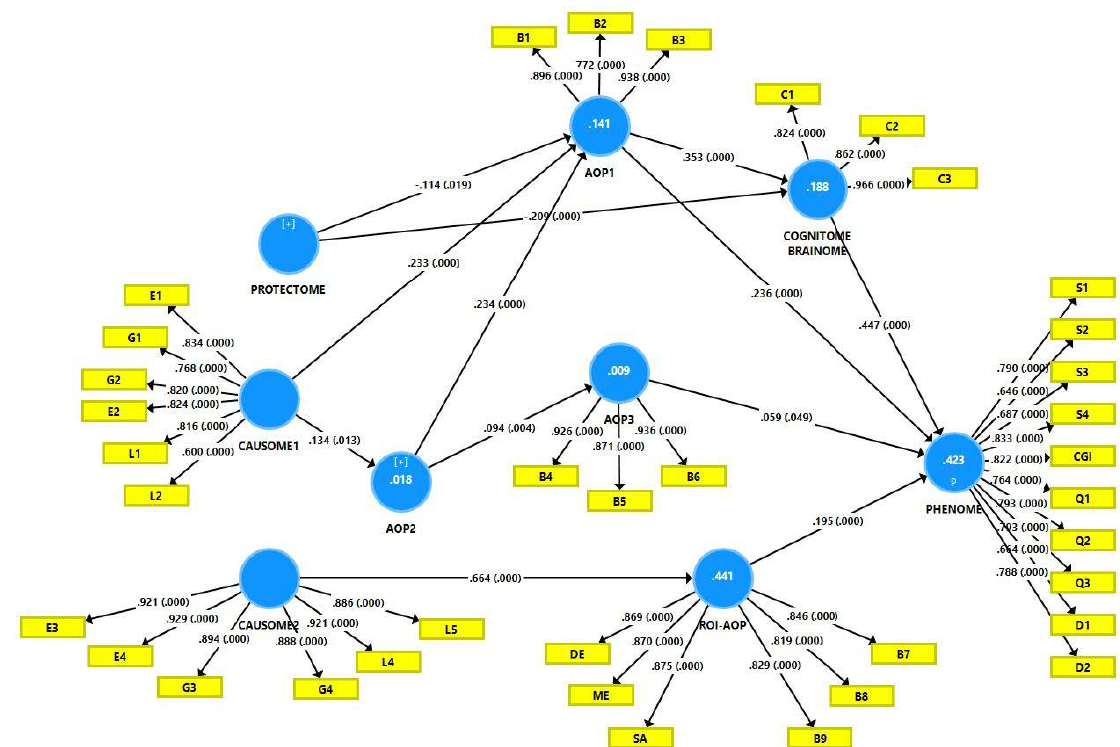
Figure 5. Example of a data-driven, bottom-up, digital model of depression in unipolar and bipolar disorder. This is an output of partial least squares (PLS) path analysis showing a multi-step mediation model linking risk-resilience factors (causome, protectome) with adverse outcome pathways (AOP), the reoccurrence of illness index (ROI), the cognitome-brainome, and the phenome of depression. G: genome markers; L: lifestyle factors; E: environmentome factors; B: biomarkers or bi- omarker sets; DE: number of depressive episodes; ME: number of (hypo)manic episodes; SA: num- ber of suicidal attempts; S: symptoms and severity of illness scores, Q: quality of life data; D: disa- bility data. ROI-AOP: a pathway phenotype, namely a common core underpinning ROI and neuro- oxidative pathways. Shown are path coefficients with exact p-value; white figures in the circles: explained variance.